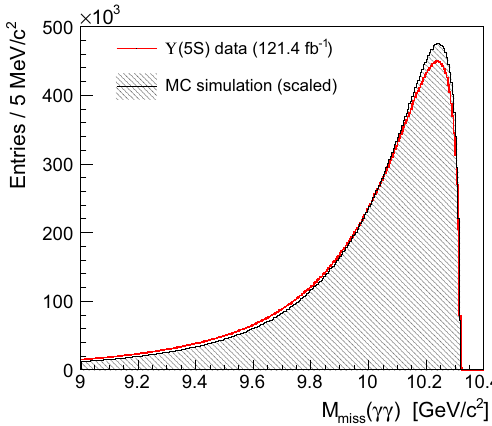
Fig. 3 Missing mass of the η candidate after the selection. The distri- bution obtained in the data (red solid histogram) is compared with the MC expectation (black shaded histogram), rescaled by a factor 1 . 49. The binning shown here is 50 times larger than the one used in the fitting